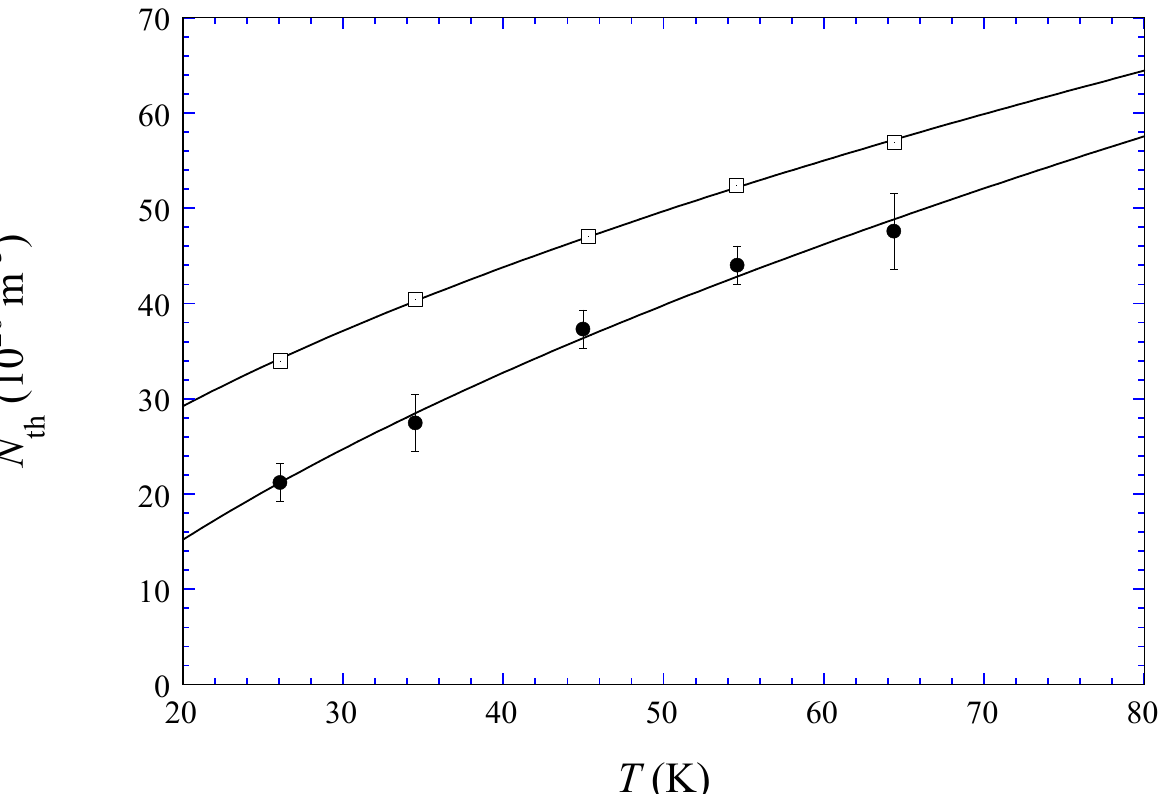
Figure 3. Temperature dependence of the threshold density N th for the onset of bubble state formation as determined by the inspection of the field dependence of µ N (closed points). Open squares: temperature dependence of the density N (cid:63) at which quasifree electrons and electron bubbles are equiprobable according to the bubble model [42]. The lines are only a guide for the